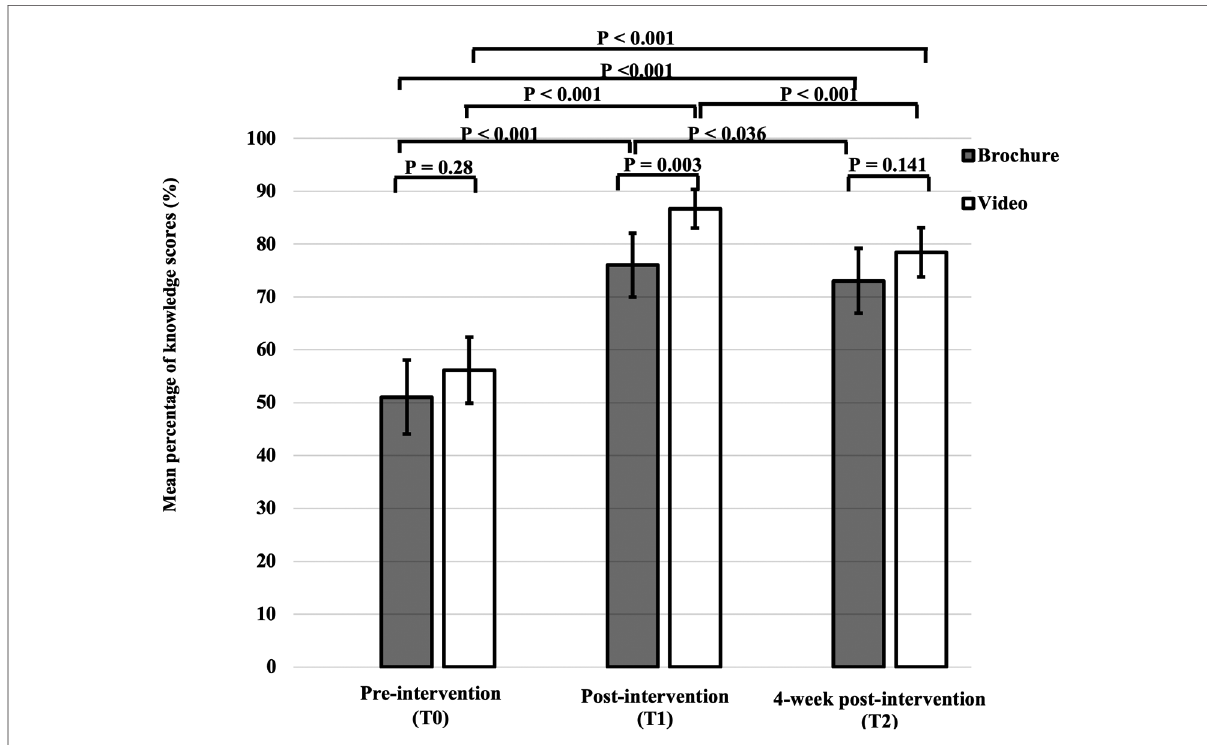
FIGURE 2 Total knowledge scores before (T0), immediately after intervention (T1) and at 4-week post-intervention (T2). Error bars are standard